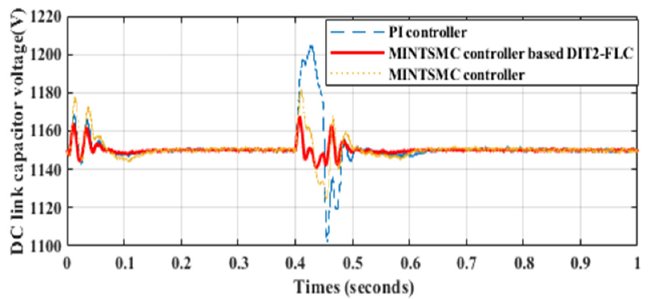
Figure 15. Capacitor DC-link voltage of the DFIG system via the PI controller, MINTSMC controller, MINTSMC controller-based DIT2-FLC.